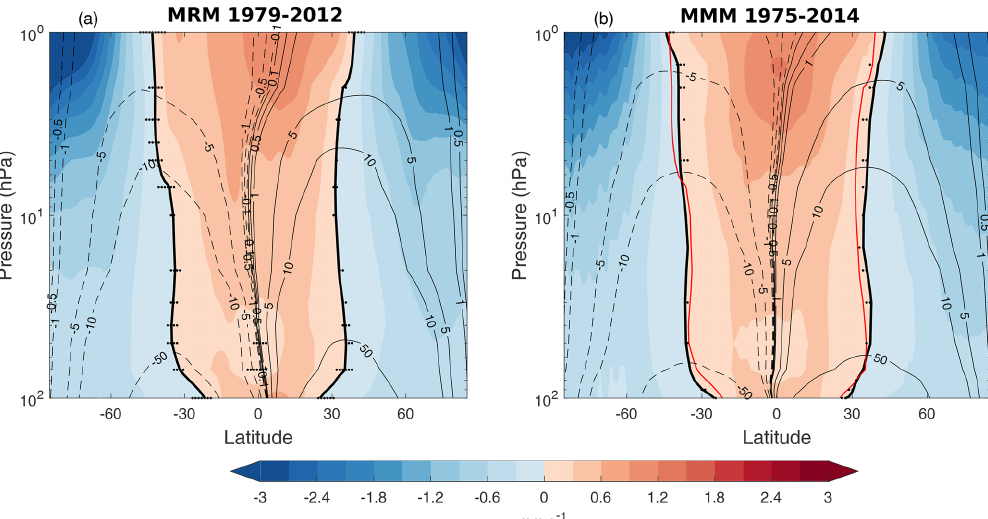
Figure 1. Annual-mean climatology for the multi-reanalysis mean (a) and multimodel mean for the historical simulations (b) of the vertical component of the residual circulation ( w ∗ , in mms − 1 , shading) and residual streamfunction ( (cid:57) ∗ , in kgm − 1 s − 1 , contours). Black thick contours indicate the location of the turnaround latitudes. The red contour in the right panel shows the turnaround latitudes for reanalyses. Black dots represent regions where there is disagreement in the sign of w ∗ for more than 66% (2 / 3) of the individual reanalyses or models (which happens only around turnaround